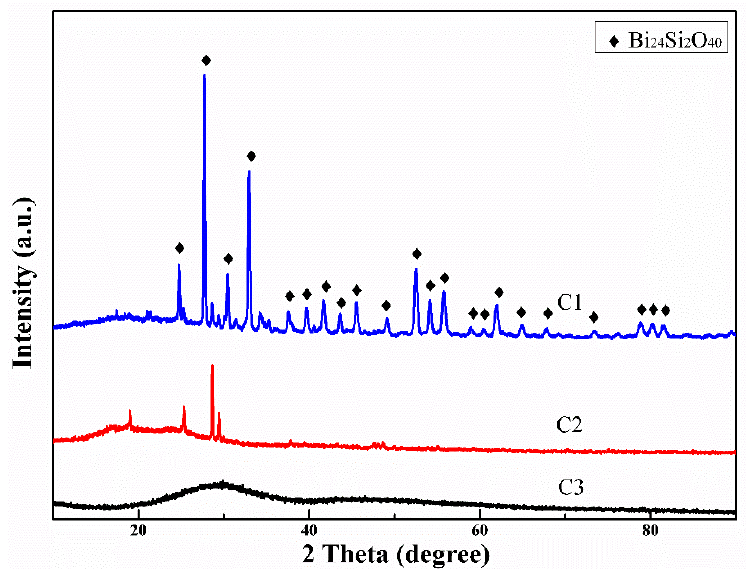
Figure 4. XRD patterns of glass before and after sintering and glass and sodium carbonate mixture after sintering. C1: glass and sodium carbonate mixed powder sintering, C2: Glass after sintering, C3: Unsintered glass.